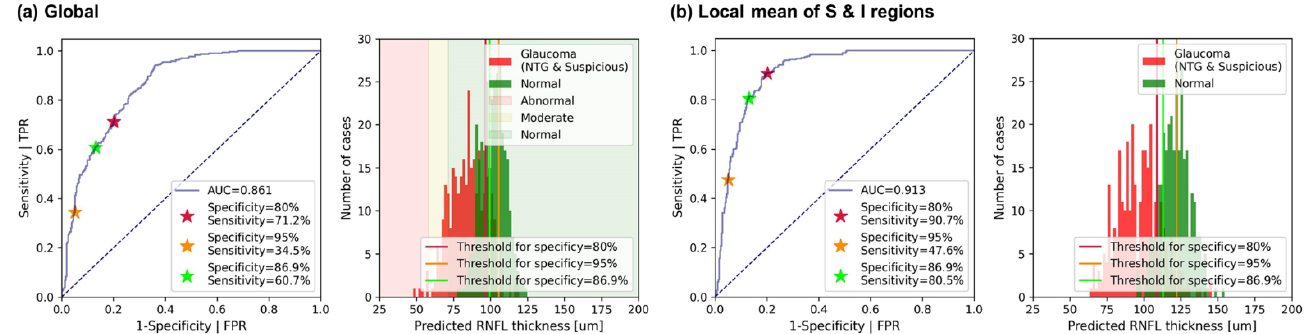
Figure 7. ROC analysis using ( a ) global RNFL predictions and ( b ) local mean of predicted RNFL thicknesses over superior plus inferior (ST, SS, SN, IN, II, IT) regions, which has the best score of AUC and sensitivity for specificity at 80%.